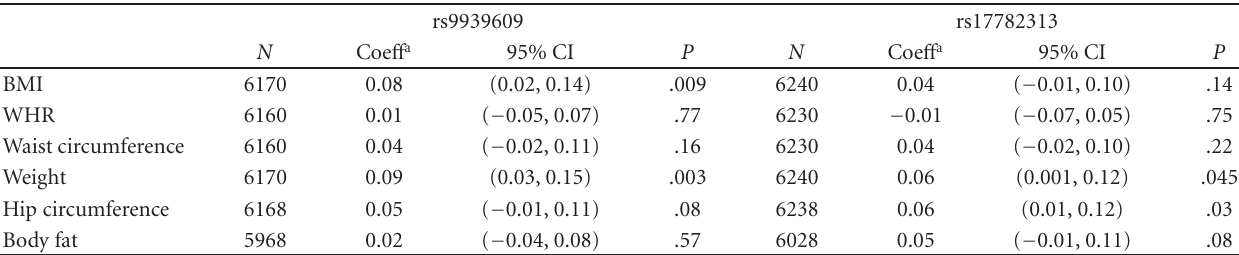
Table 2: Associations of SNPs in FTO and MC4R genes with age, sex adjusted Z scores of obesity